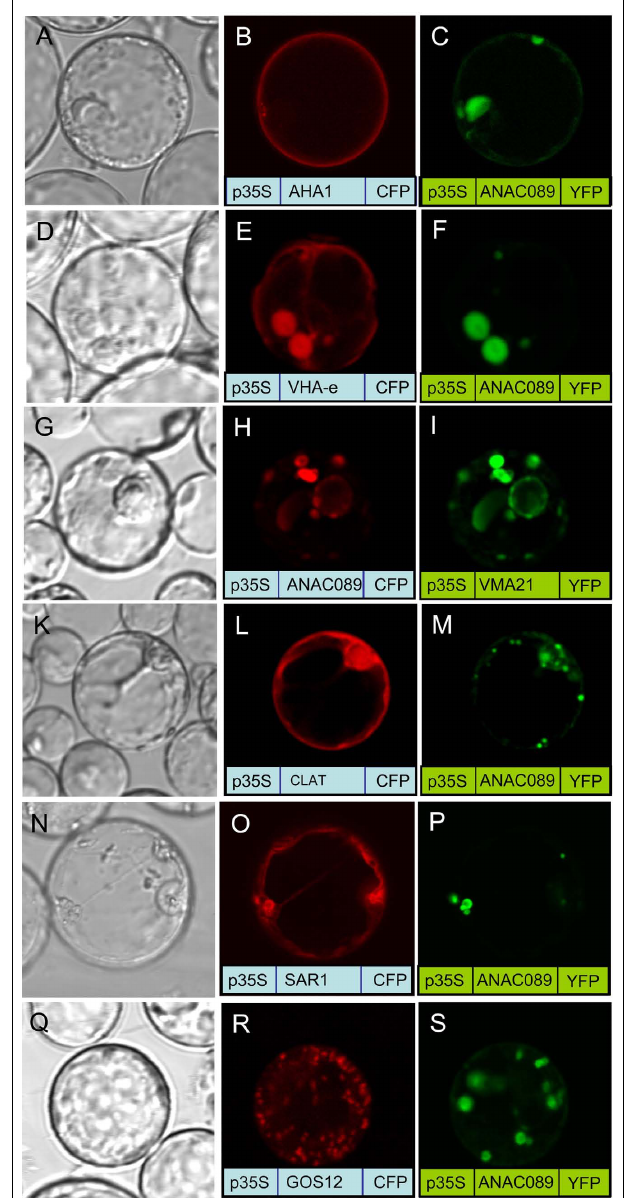
FIGURE 6 | Co-localization of fluorophore-fusedANAC089 with marker proteins. Protoplasts were co-transfected with ANAC089 fused to either CFP orYFP as indicated and a marker protein as follows: ( A – C) AHA1, the plasmamembrane H + -ATPase, (D – F) VHA-e, a subunit of theV 0 domain of V-ATPase that localizes toTGN/EE, (G – I) VMA21a, an ER-resident assembly factor of theV-ATPas, (K – M) Clathrin, the light chain of the clathrin coat, (N – P) Sar1, the small GTPase of COP II vesicle transport anterograde transport between ER and Golgi, and (Q – S) GOS12, a Golgi SNARE. detected in protoplasts transfected with the mutated promoter proving the importance of the CACG-element in the suppres- sive regulation. The same suppressive effect was detected when using the full length sapx promoter in the absence or presence of co-expressed ANAC089 ( Figure 7B